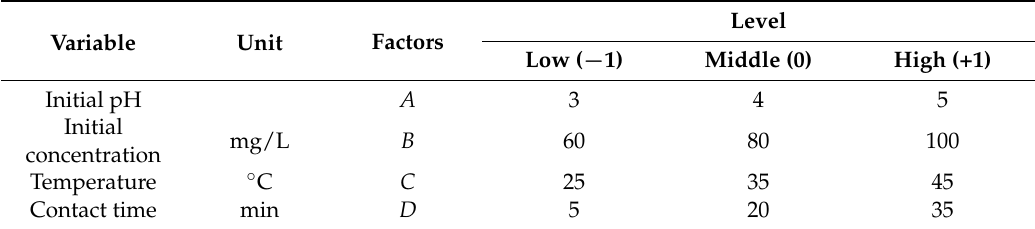
Table 1. Levels of variables chosen for the Box-Behnken